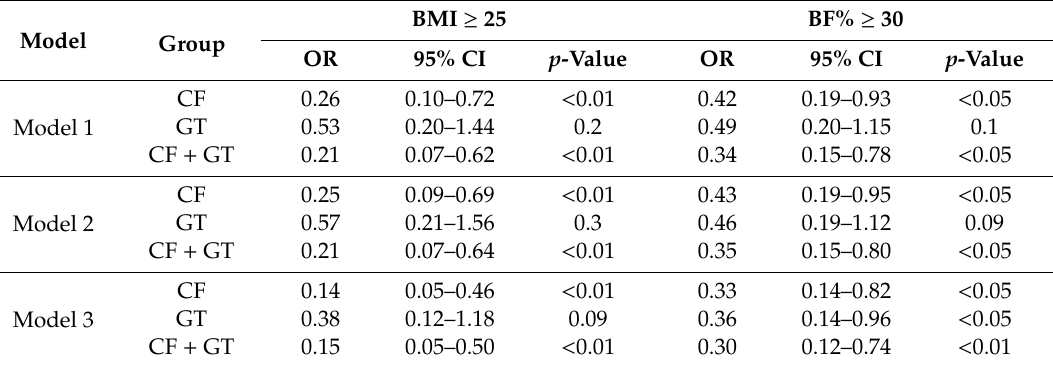
Table 2. Multivariate analysis of the associations of daily co ff ee (CF) and green tea (GT) consumption with high body mass index (BMI) and body fat percentage (BF%).